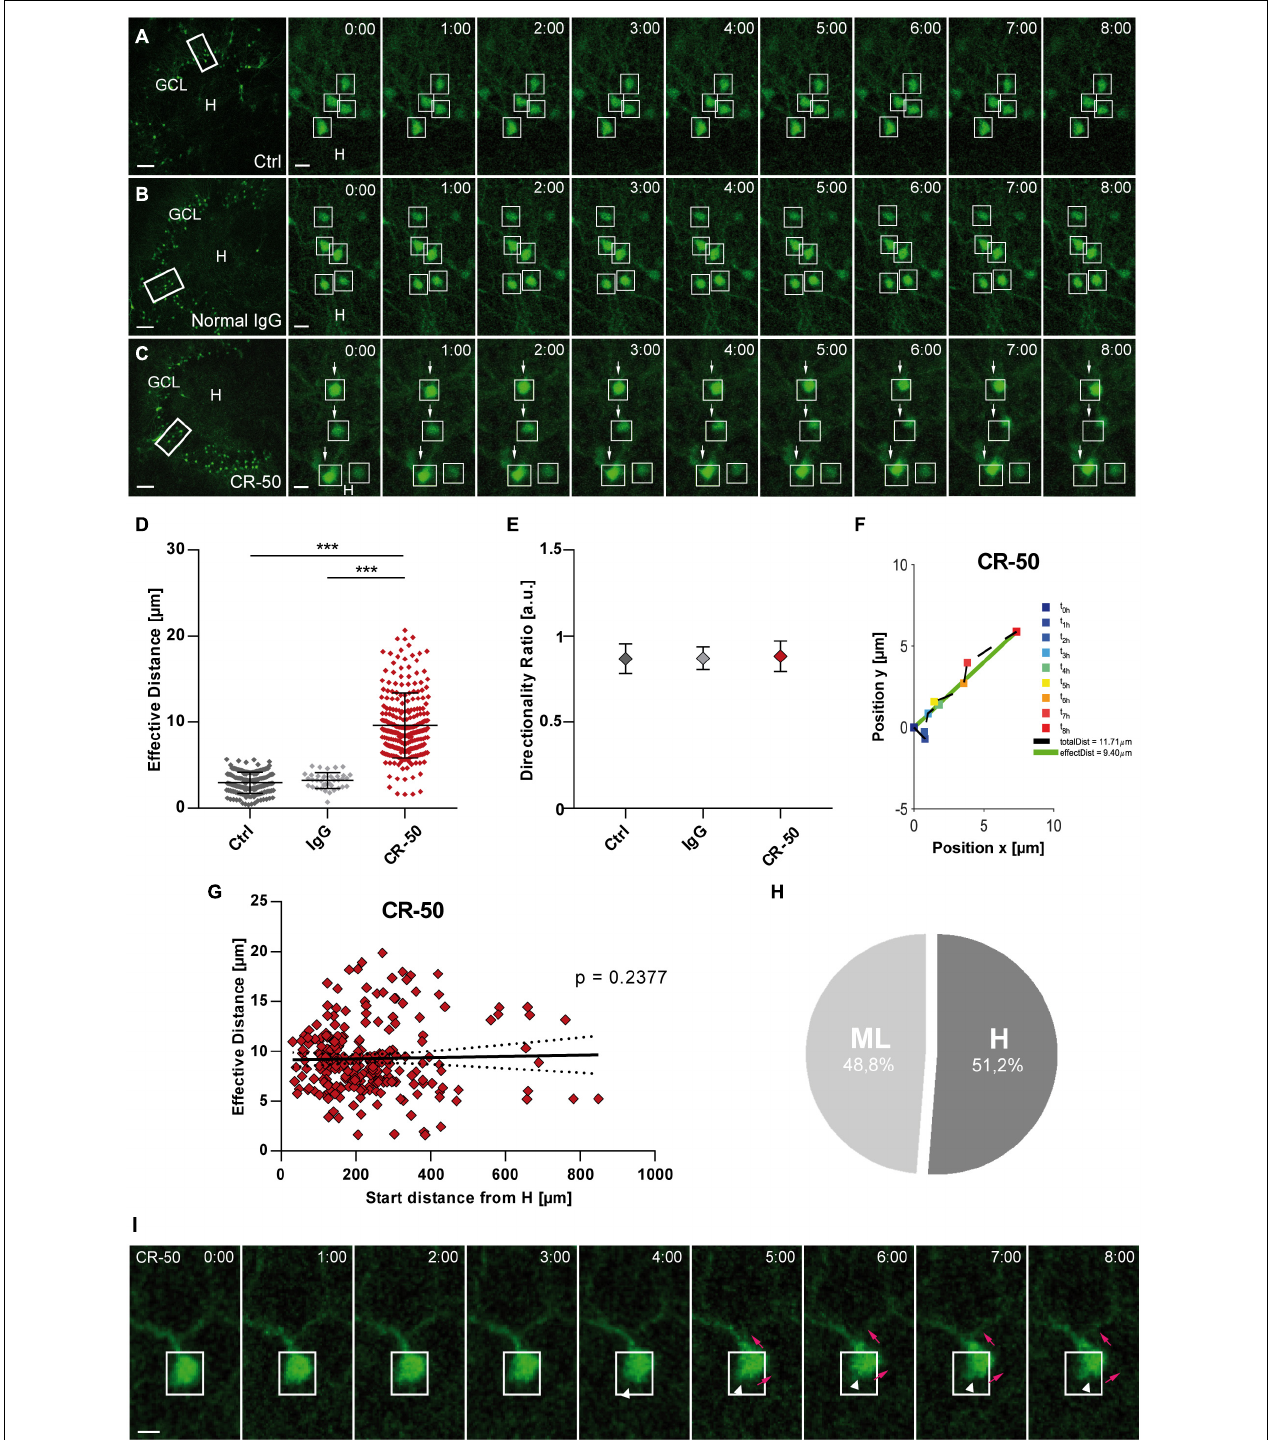
FIGURE 6 | Neutralization of Reelin in the healthy hippocampus leads to migration of mature granule cells. Live cell imaging of individual eGFP-positive GCs was performed over a period of 8 h, and migration distances of automatically selected cells were assessed. (A–C) Representative confocal micrographs of nine imaging time points are shown for each condition. Left panel: overview; white frame indicates the area shown at high magnification on the right. Tracked cells are marked by white frames. (A) Untreated control. GCs do not change position. (B) OHSC incubated with normal mouse IgG (8 µ g/mL). As in controls, there is no neuronal displacement. (C) OHSC incubated with neutralizing CR-50 antibody (8 µ g/mL). GCs with high motility are indicated by arrows. (D) Comparison of effective